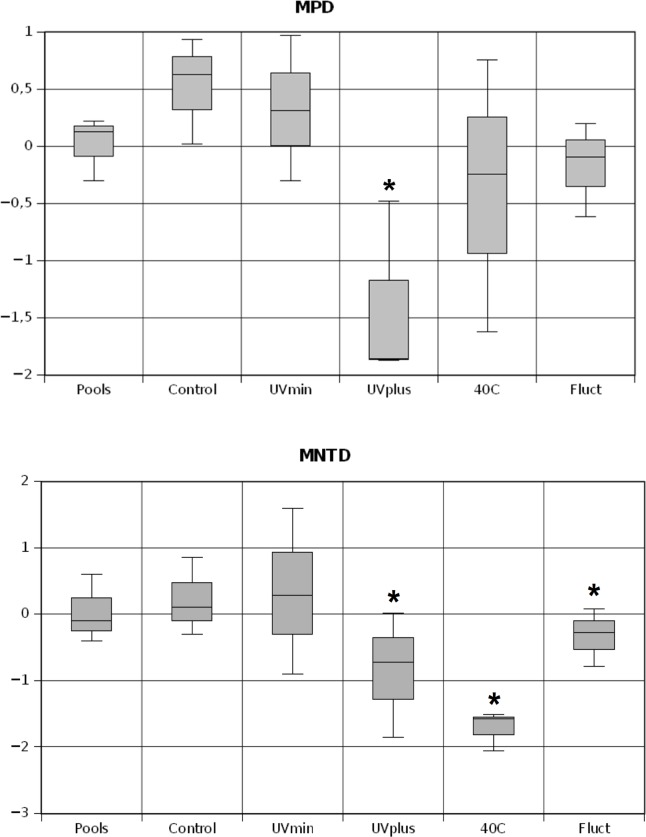
Box-and-whisker plots comparing the phylogenetic mean pairwise distance (MPD) and the mean nearest taxon distance (MNTD) values for the bacterial OTUs between pools and treatments.Asterisks indicate communities that are significantly structured at p< 0.05 level.